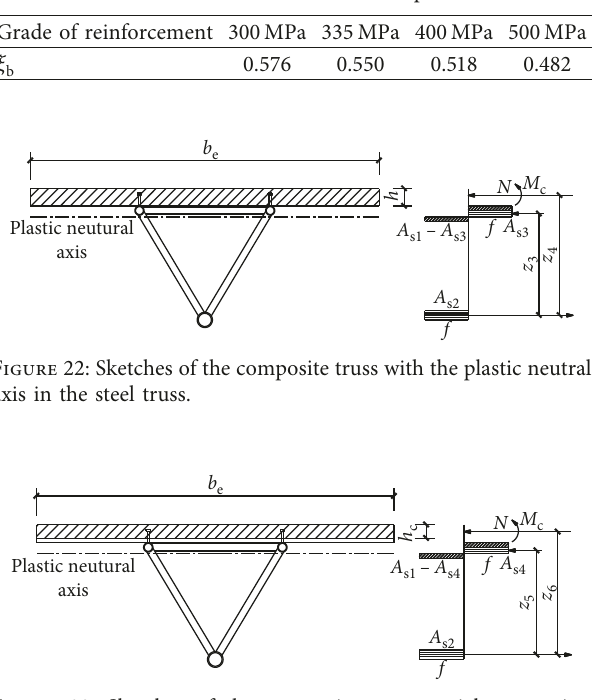
Figure 24: Comparison between the predicted results and FE